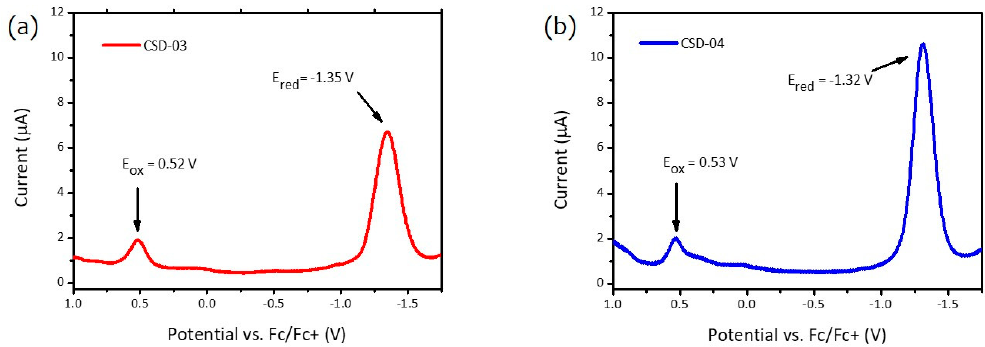
Figure 2. Square wave voltammetry of ( a ) CSD-03 and ( b ) CSD-04 . Table 1. Summary of optical and electrochemical properties of the as-synthesized dyes.